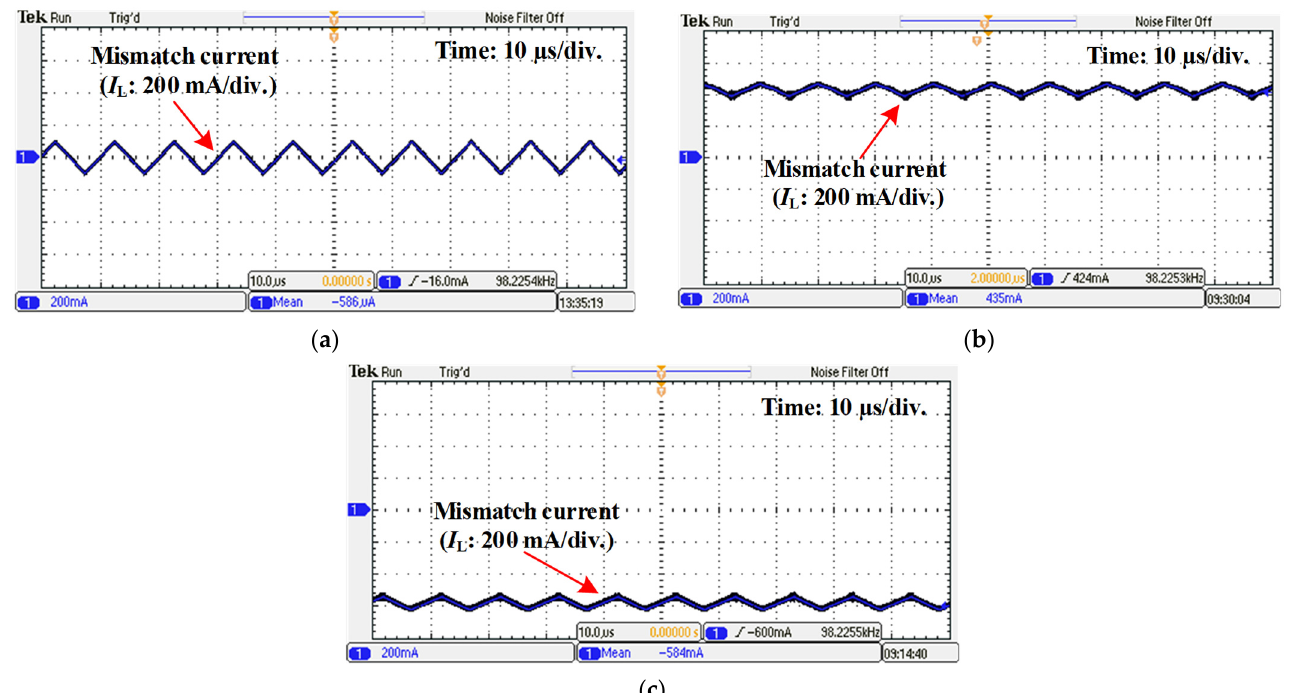
Figure 12. Experimental results showing mismatch current ( I L ) for various test conditions in Table 5 for SCL -based DPP topology. ( a ) Test 1 ( b ) Test 2 and ( c ) Test 3.